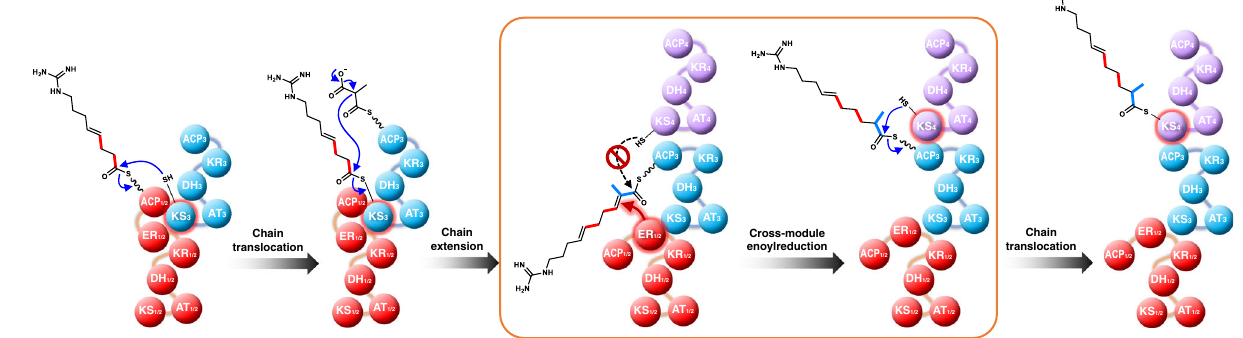
Fig. 6 | Illustration of the proposed mechanism of cross-module enoylreduc- tion in AZL biosynthesis. The core of the proposed mechanism is highlighted in the orange box, indicating that only when completion of